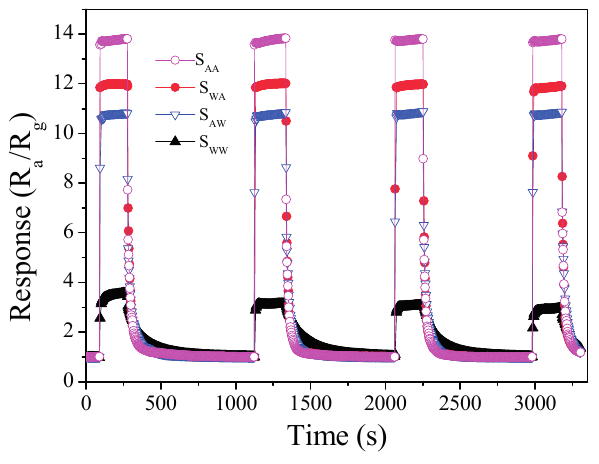
Figure 6. Responses to 50 ppm acetone gas for S AA , S WA , S AW and S WW at 250 °C .